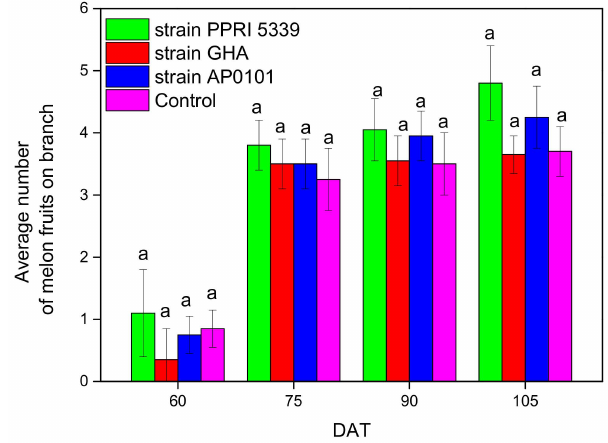
Figure 8. Average number of fruits per C. melo branch inoculated with B. bassiana . Treated plants were watered with 10 mL of B. bassiana conidial suspension of 10 8 conidia/mL at the stage of four leaves, and means of the same DAT marked with the same letter did not differ significantly (Tukey-Kramer test, p < 0.05); DAT: days after treatment. The average number of male and female flowers, of C. melo was also recorded. The number of male flowers per plant ranged from 2.3 ± 0.5 ( B. bassiana GHA) to 6.8 ± 1.1 ( B. bassiana AP0101) and of female flowers from 1.1 ± 0.4 ( B. bassiana GHA) to 2.7 ± 0.4 ( B. bassiana PPRI 5339) (Figure 9). Statistically significant differences were recorded between male (F = 8.766, df = 3, 214, p = 0.038) and female flowers (F = 6.112, df = 3, 214, p = 0.048). The fewest flowers were counted in melon plants treated with B. bassiana GHA.